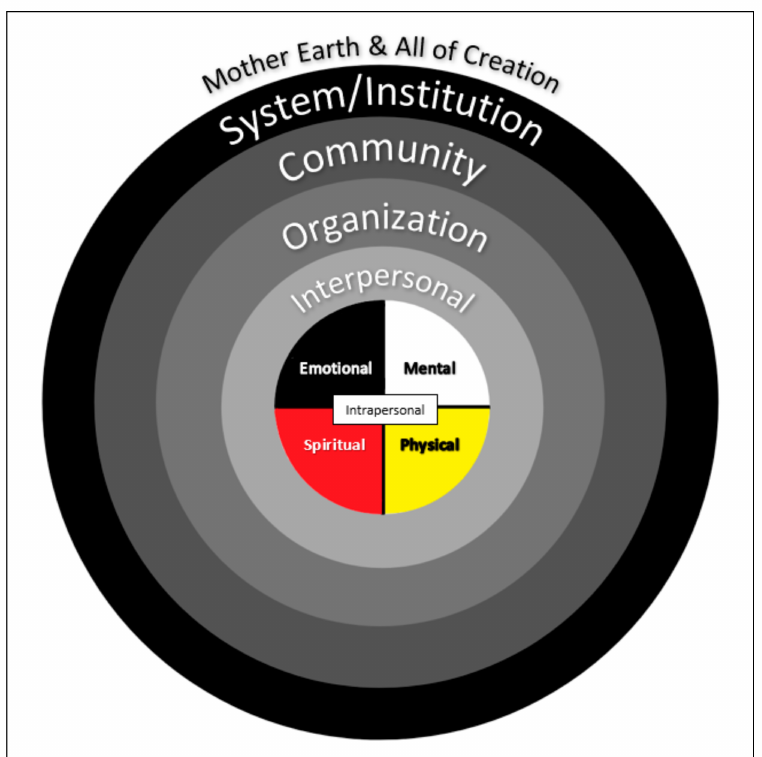
Figure 2. The Integrated Indigenous-ecological model, adapted from Lavall é e [31] and Lavall é e and L é vesque